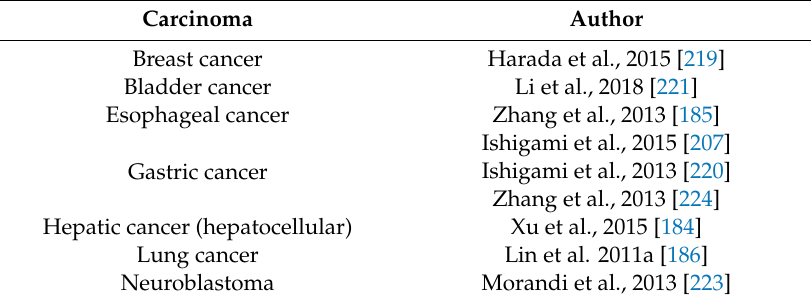
Table 4. Studies showing expression of HLA-F in malignant